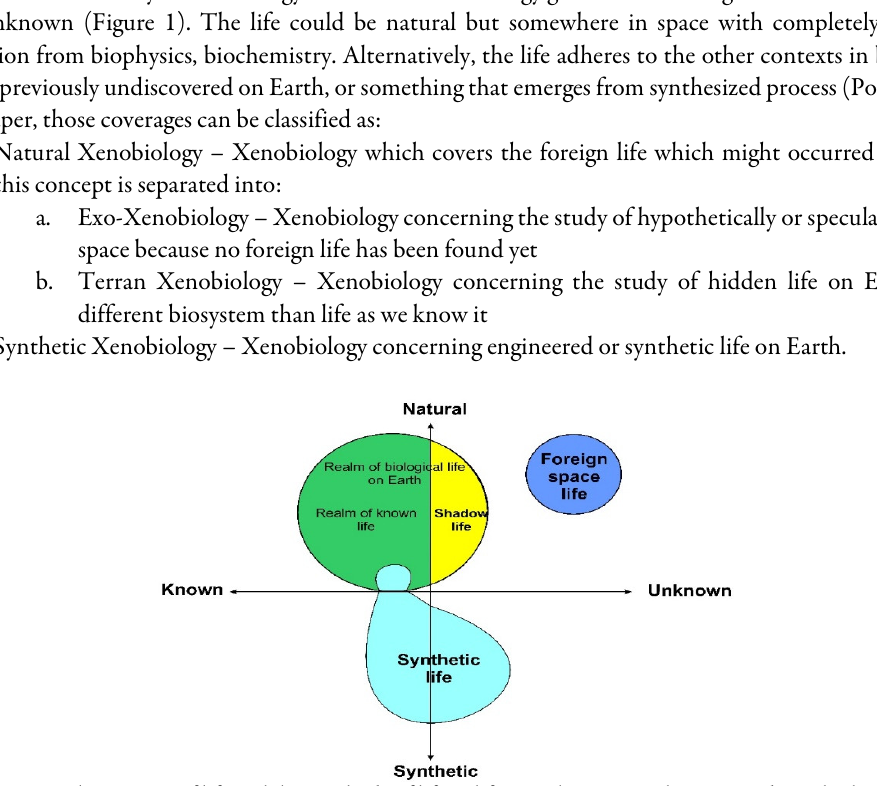
Figure 1. The concept of life with known body of life or life as we know it vs. the estranged xenobiological components between two axes of known-unknown aspect and natural-synthetic